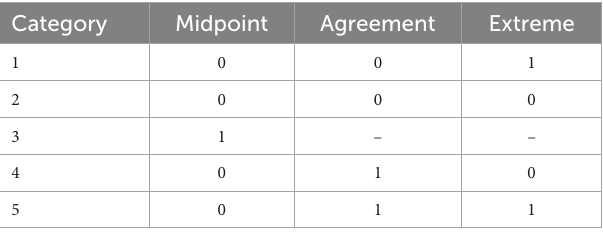
TABLE 2 Pseudo-items matrices for five-category